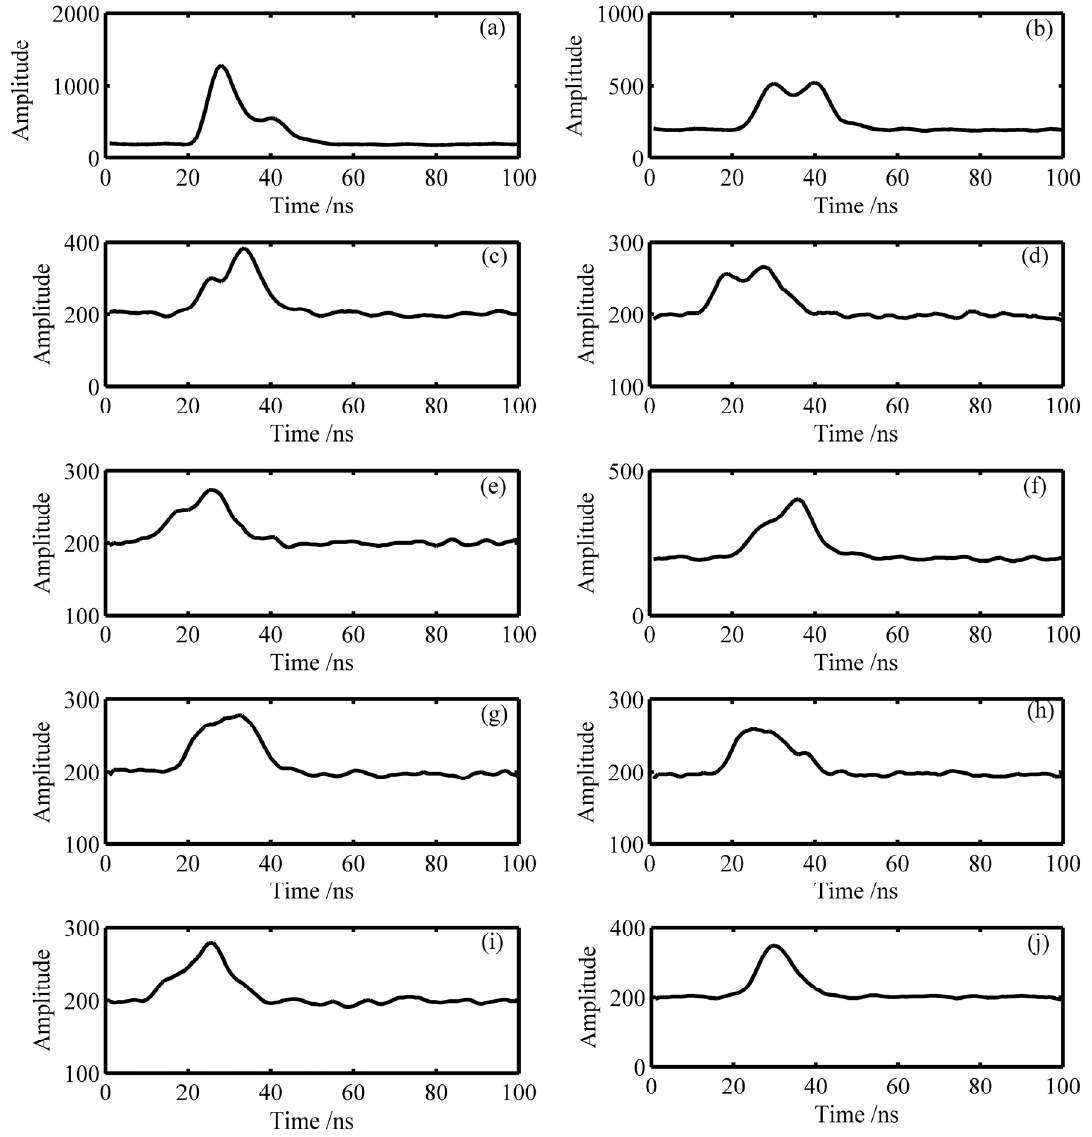
Figure 2. Typical bathymetric return waveforms. ( a – d ) are from clear water with multiple visible peaks of varying peak amplitude; ( e – f ) contain more subtle evidence of multiple peaks; ( g – i ) contain multiple peaks that overlap and are visibly not discernible; ( j )